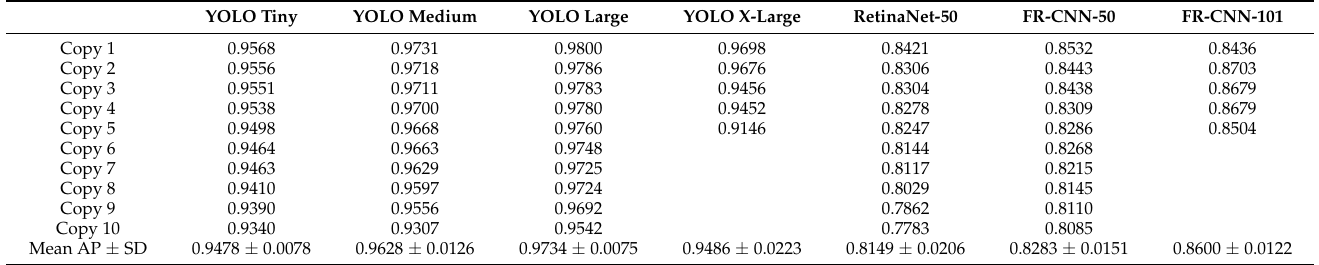
Table A1. AP values of all individually trained copies of each detector type and size, ranked highest to lowest.